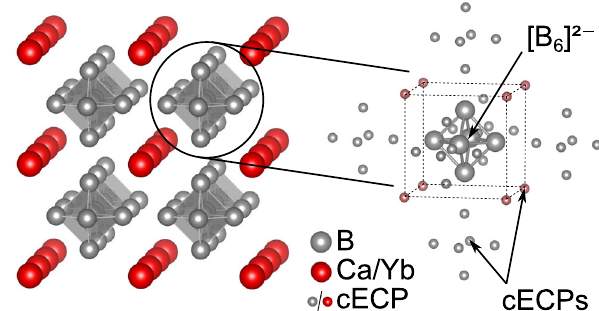
Fig. 1 Cubic crystal structure of MB 6 hexaborides and B 6 2 − quantum mechanical cluster. The quantum cluster is surrounded by 44 nearby ions modeled as capped effective core potentials (cECPs). Dashed lines highlight the cubic M 8 cage around a given B 6 octahedron (red: Ca/Yb, light grey: